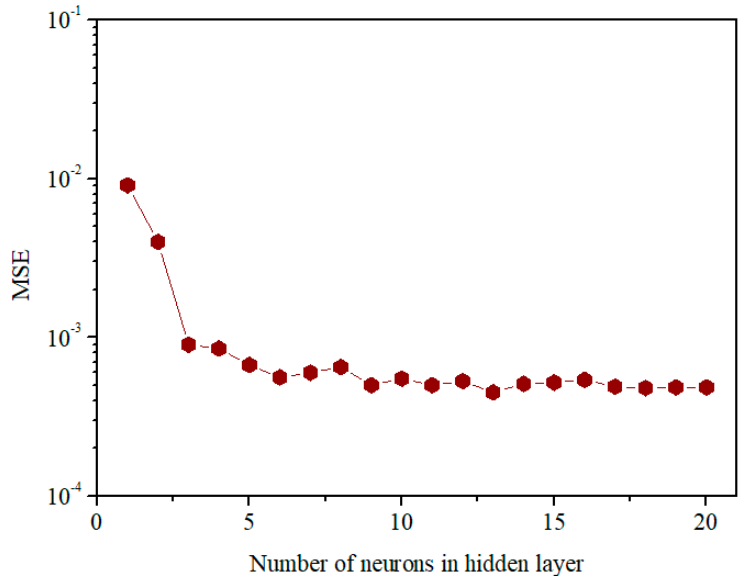
Figure 3. The MSE with respect to the number of neurons in the hidden layer.